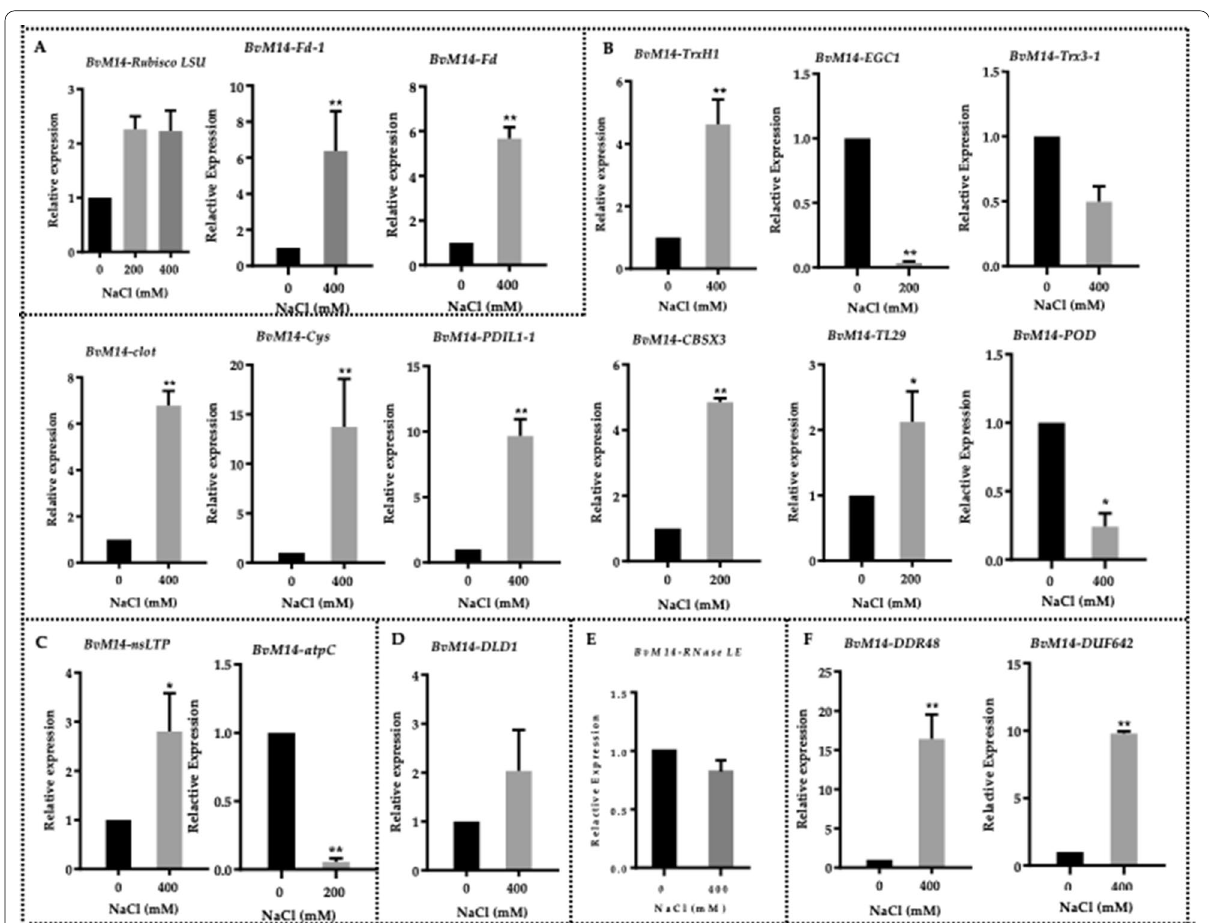
Fig.4 Real-time PCR analysis of the genes encoding the differential redox proteins and differential proteins in different pathways. A Photosynthesis, B ROS homeostasis, C Transport, D Metabolism, E Biosynthesis, and F Stress and defense. The x-axis is salt concentration. The y-axis is the relative expression of each gene (2 − ΔΔCT ). Asterisks represent significant differences (*p < 0.05, **p < 0.001) determined by one-way ANOVA followed by Tukey’s HSD